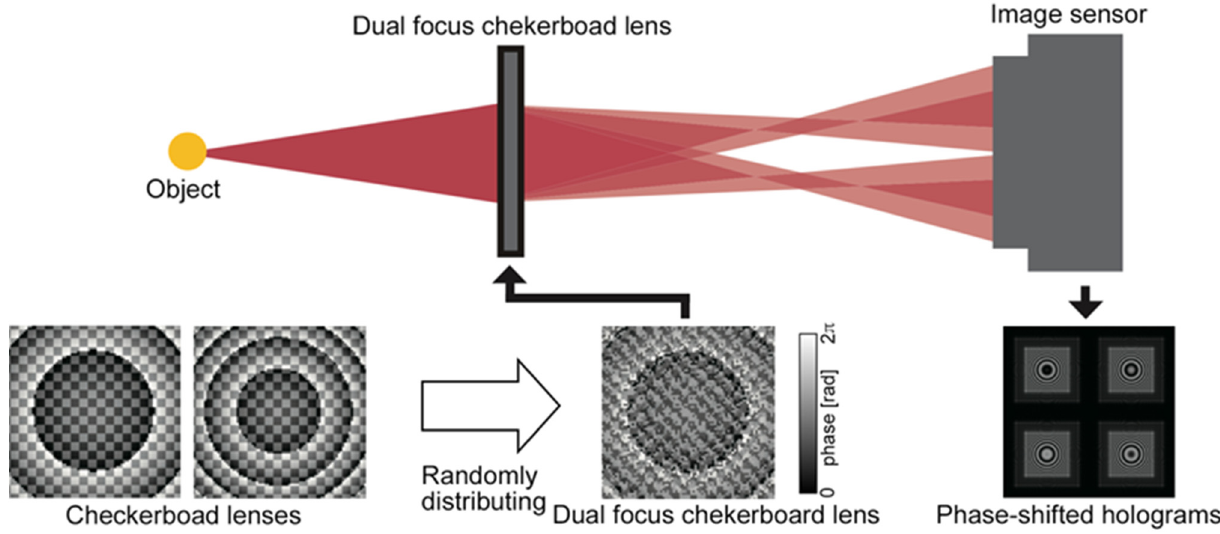
Figure 4. FINCH setup using a dual-focus checkerboard lens for parallel phase shifting.